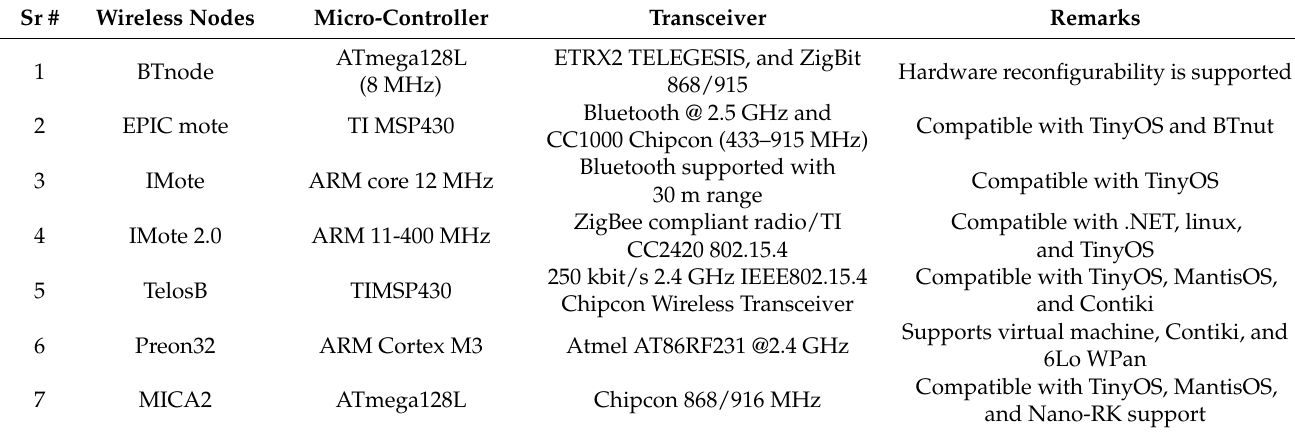
Table 3. Common wireless nodes used in the agriculture